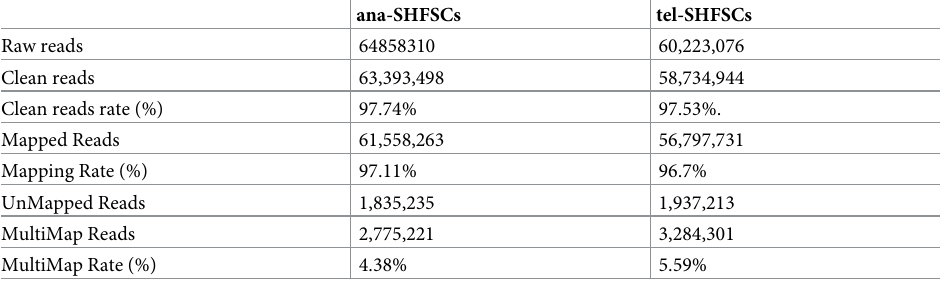
Table 2. Summary of mapped read and mapping rates based on the RNA-Seq